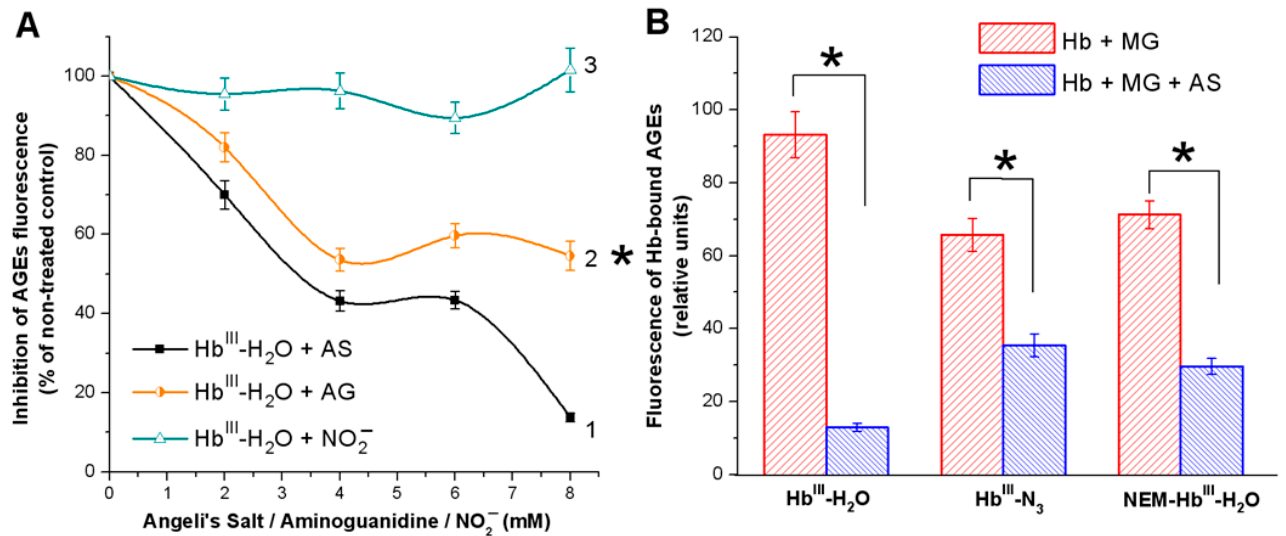
Figure 2. Formation of fluorescent advanced glycation end products (AGEs) in hemoglobin (Hb) reaction with methylglyoxal (MG). ( A ) effect of Angeli’s salt—1, of aminoguanidine—2, and of nitrite ions (NO 2 − )—3; ( B ) effect of Angeli’s salt (8 mM) on Hb modified with NaN 3 and NEM. Reaction mixture in ( A , B ): 0.15 mM of oxidized hemoglobin (metHb) in 50 mM PBS (pH 7.4), 54 mM MG. Results are depicted as the mean with S.E.M. of three independent experiments ( n = 3). Two-way ANOVA ( A ) (* p ≤ 0.05), student t -test ( B ) (* p ≤ 0.05).